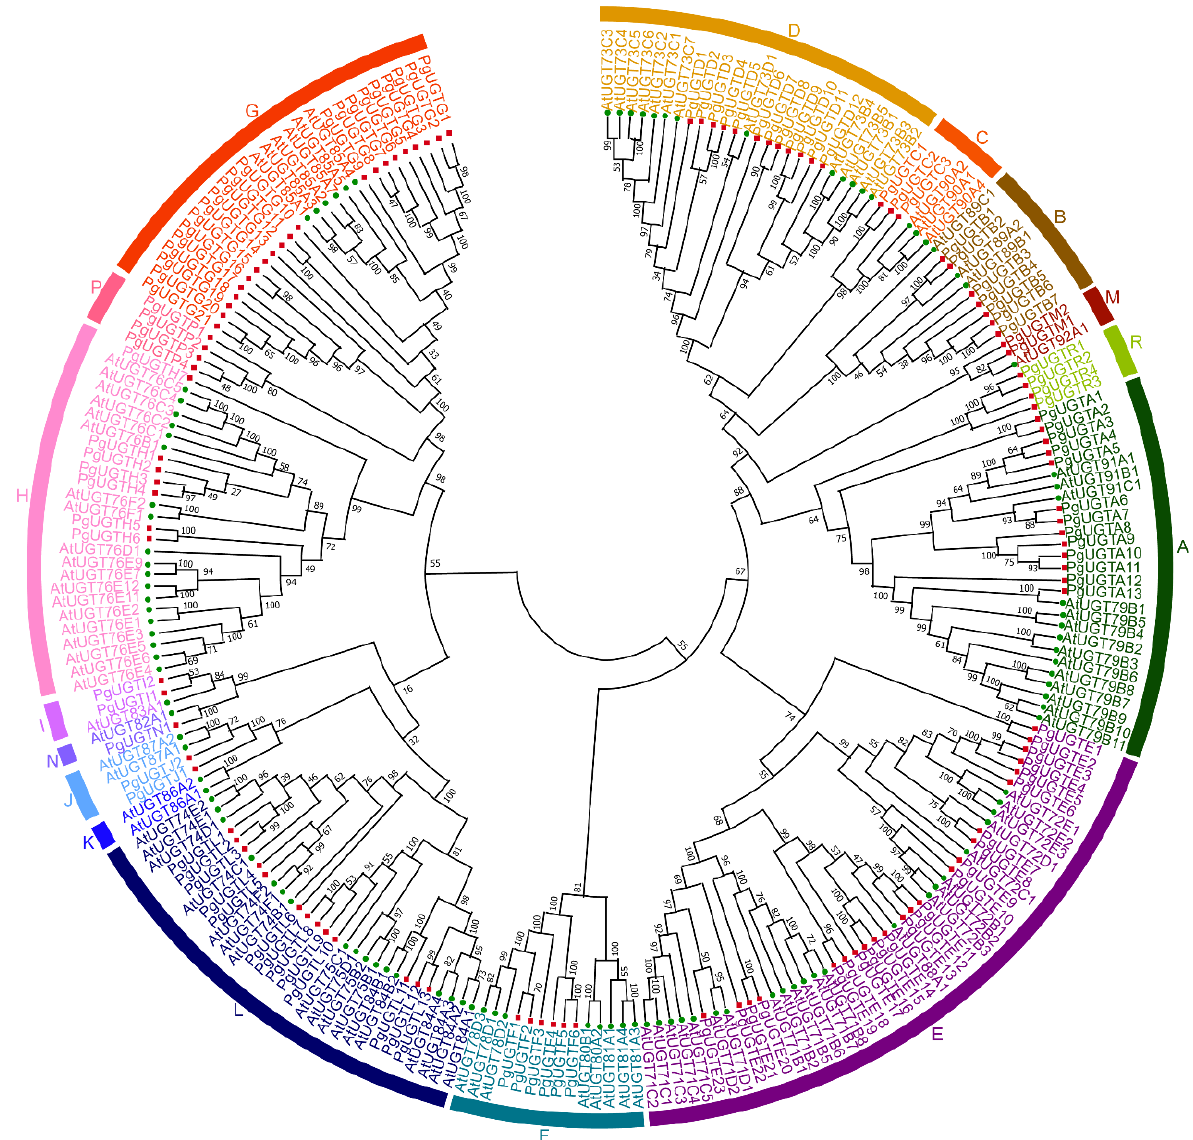
Figure 1. Phylogenetic analysis of UGT proteins in pomegranate and Arabidopsis . The capital letters (A–J, L–N, P, and R) represent different groups. The phylogenetic tree was generated by the neighbor- joining method using MEGA 10 software with 1000 bootstrap